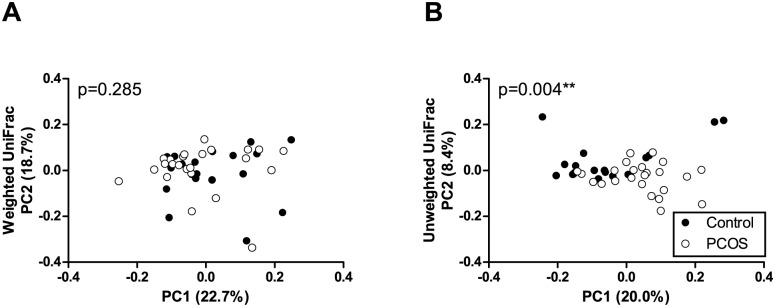
Principal coordinate analysis (PCoA) plots of stool samples from PCOS patients and controls.PCoA plots of weighted (A) and unweighted (B) UniFrac distance matrices. Each dot represents the bacterial community composition of one individual stool sample. Axis titles indicate the percentage variation explained.